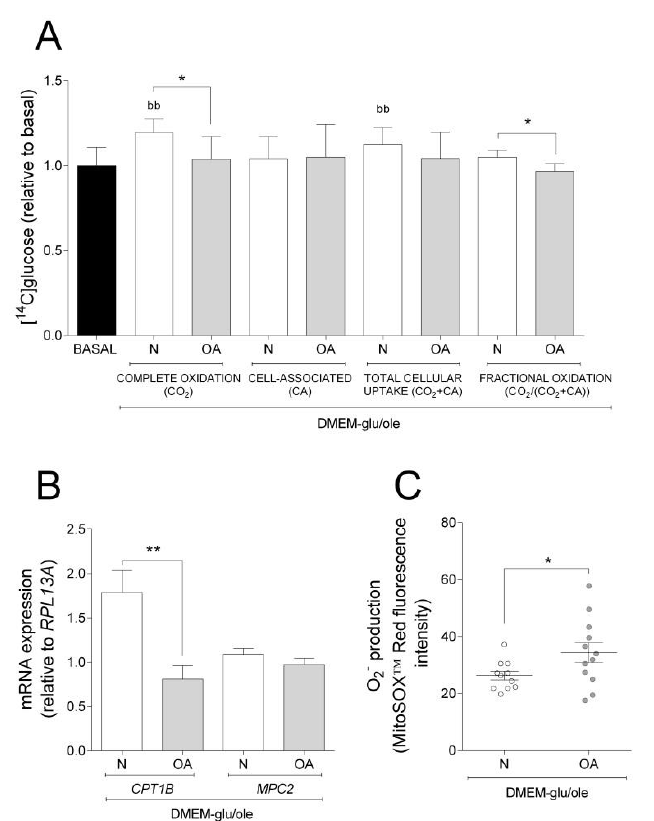
Figure 2. E ff ect of oleic acid on glucose metabolism, mRNA expression, and O 2 − production. E ff ect of culturing cells in DMEM-glu / ole (i.e., DMEM 5.5 mM glucose supplemented with 100 µ M oleic acid) compared to DMEM-glu (basal, i.e., DMEM 5.5 mM glucose). ( A ) Glucose metabolism. ( B ) mRNA expressions of carnitine palmitoyltransferase 1B ( CPT1B ) and mitochondrial pyruvate carrier 2 ( MPC2 ) normalized to the expression of RPL13A . ( C ) Anion superoxide production (O 2 − ). N and OA data included the values for haplogroups H and J combined. All data were obtained from three independent experiments, each with four replicates and two clones per donor. Values are presented as mean ± SEM relative to basal. * Statistically significant di ff erence between N and OA cybrids (* p ≤ 0.05, ** p ≤ 0.01, unpaired t -test). b Statistically significant versus basal ( bb p ≤ 0.01, paired t -test). N, healthy cybrids; OA, osteoarthritis cybrids.